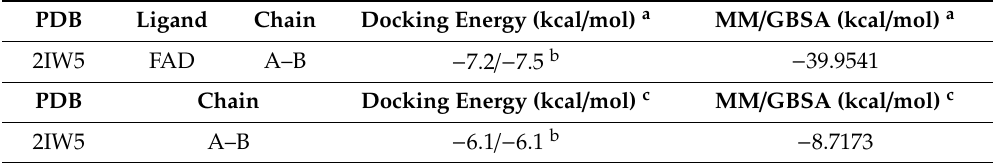
Table 1. Binding energies of oleacein against LSD1.